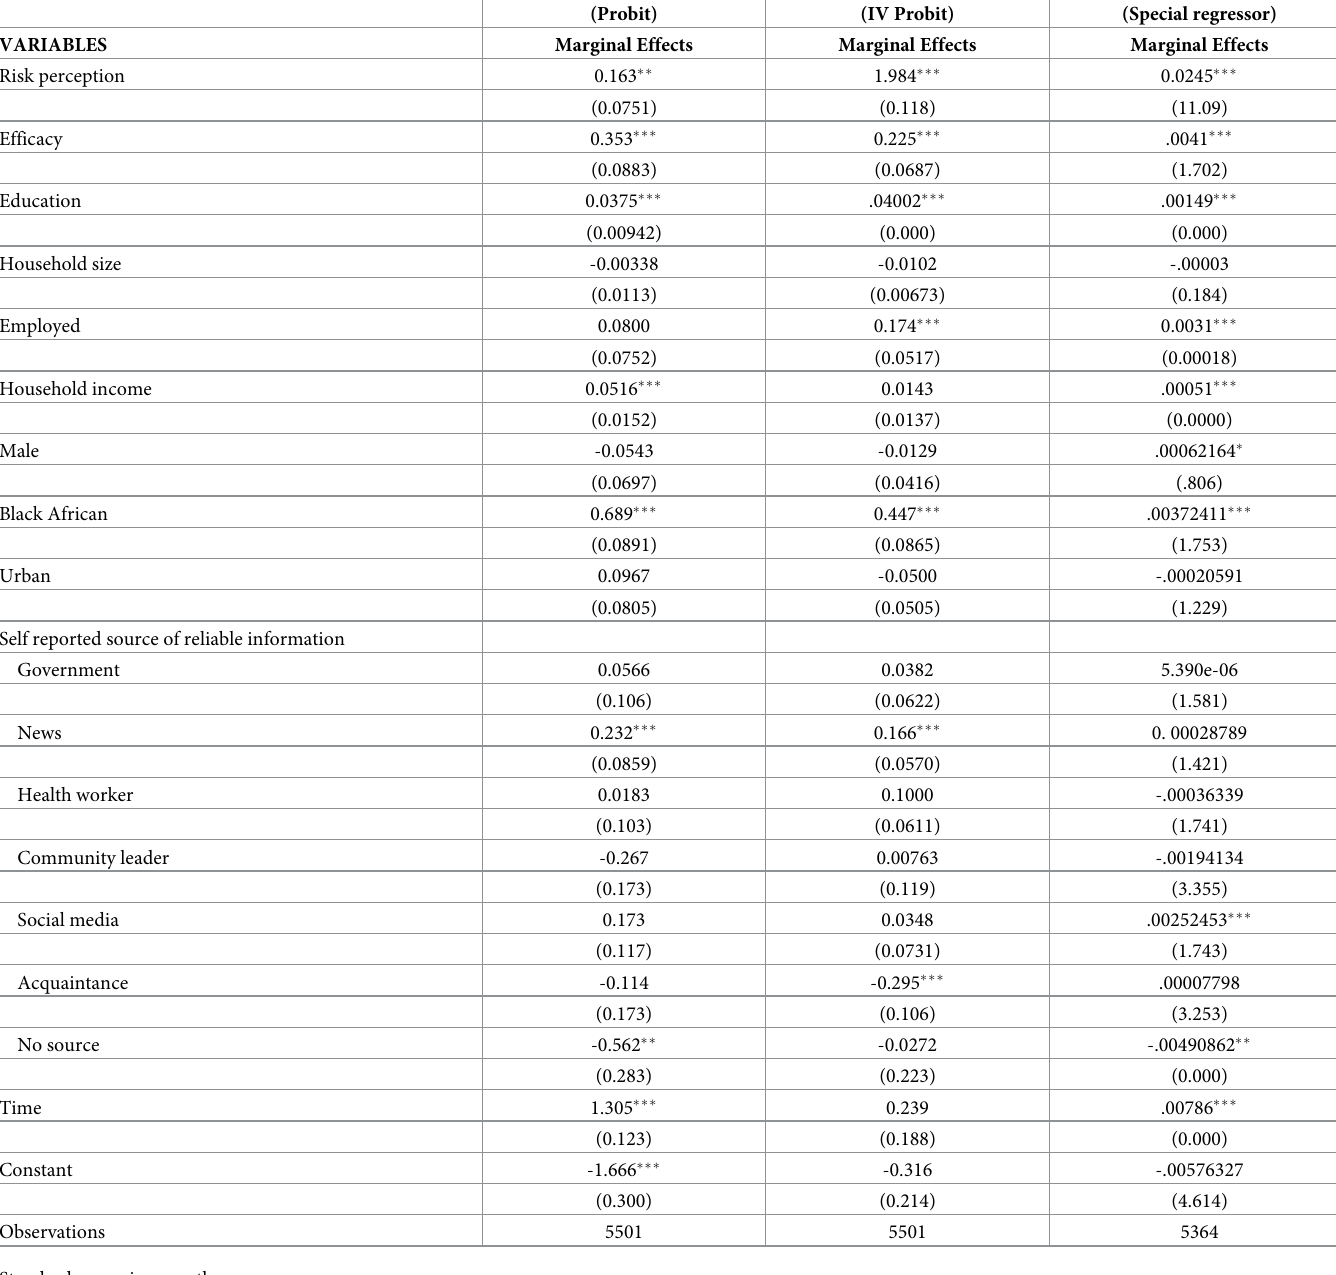
Table 6. Multivariate analysis (dependent variable: Behavioural